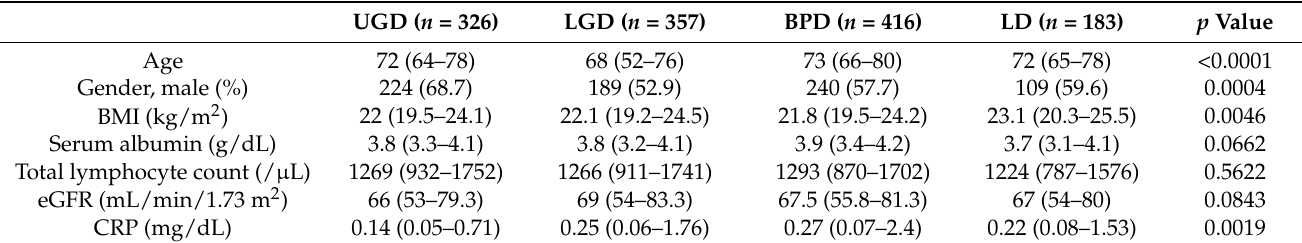
Table 2. A comparison of baseline characteristics among 4 groups of UGD, LGD, BPD, and LD.